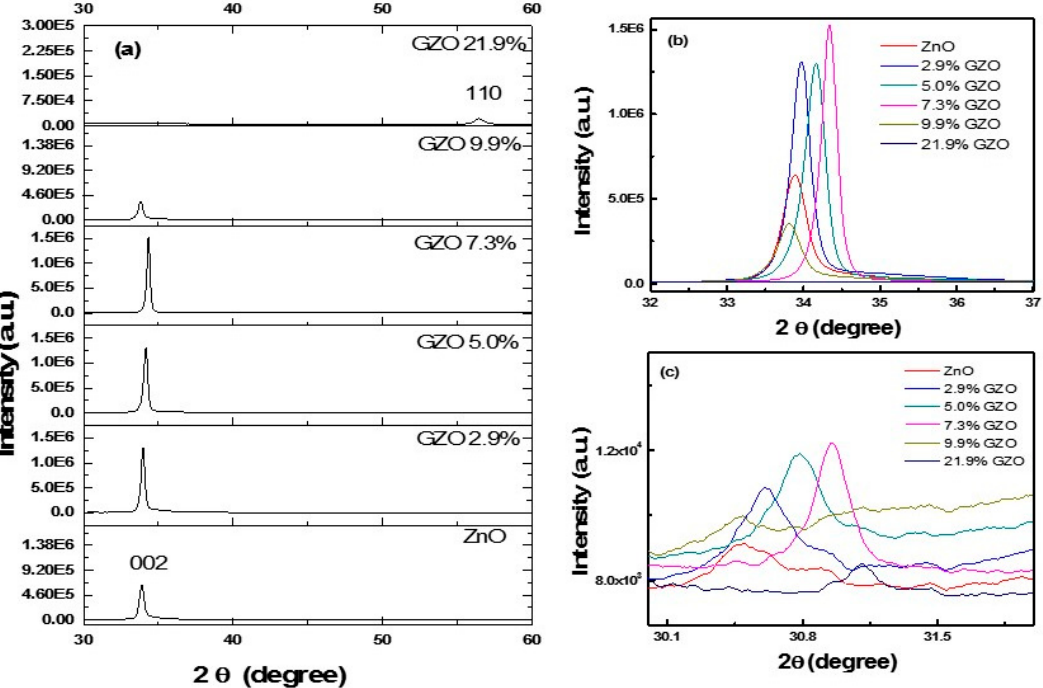
Figure 3. ( a ) XRD patterns of the GZO films; ( b ) the enlarged view of the diffraction peak of (002), showing the shifting of the diffraction peak position; ( c ) the enlarged view of the diffraction peak of (100), showing the shifting of the diffraction peak position.